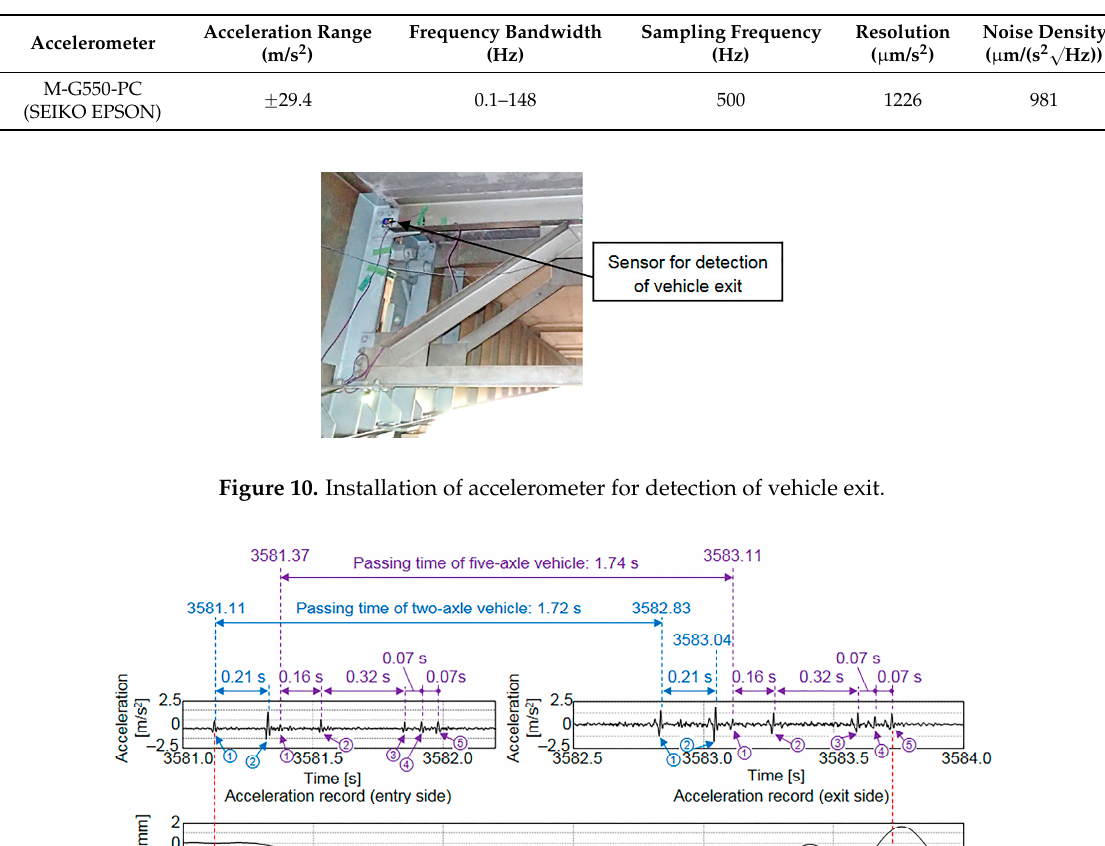
Table 3. Specifications of accelerometers used to detect vehicle entry and exit.